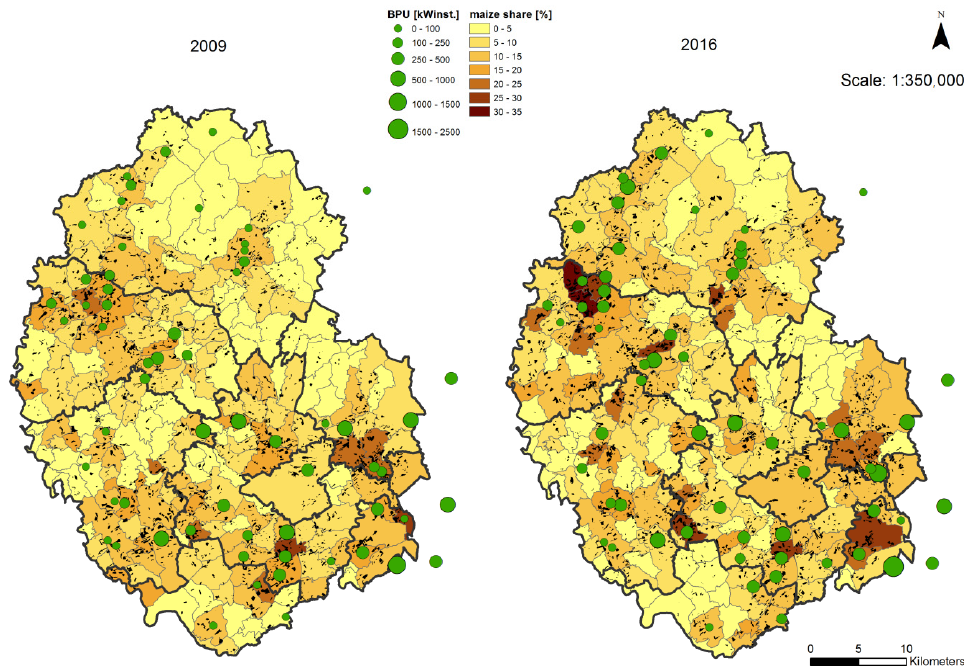
Figure 4. Representation of silage maize cultivation (black spots) and of the share of silage maize cultivation on agricultural 4 land use based on the municipalities of the study area. Moreover, the location and size of the biogas producing units (BPU) is